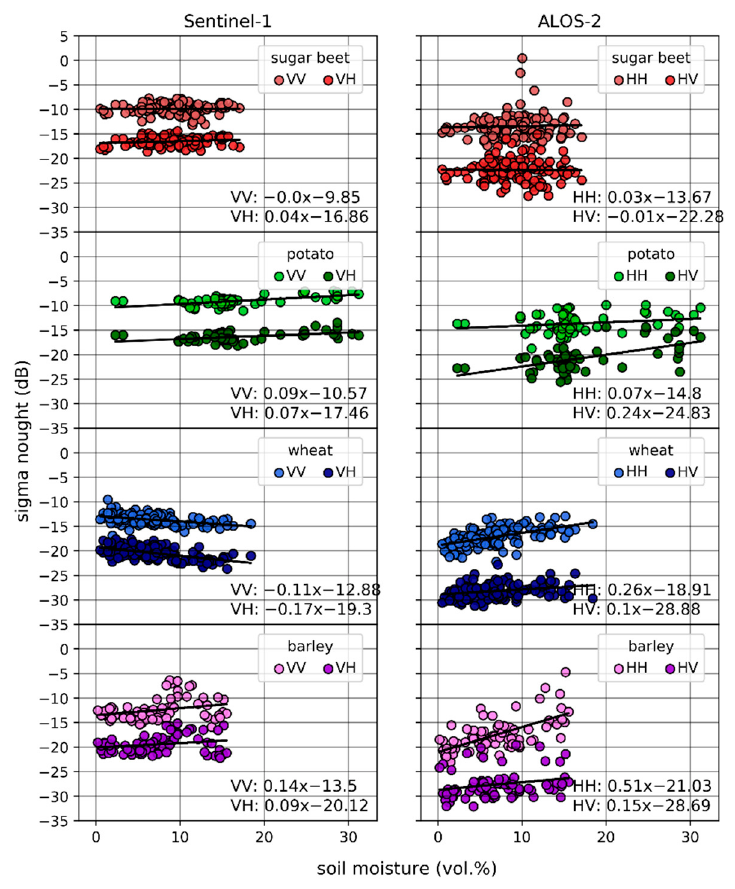
Figure 10. Scatter plots between soil moisture and backscattering signal from co- and cross-polarized channels of C- and L-band satellite data. Table 4. The coefficient of determination (R 2 ) and Root Mean Square Deviation (RMSD) of the linear regression between backscattering signal and soil